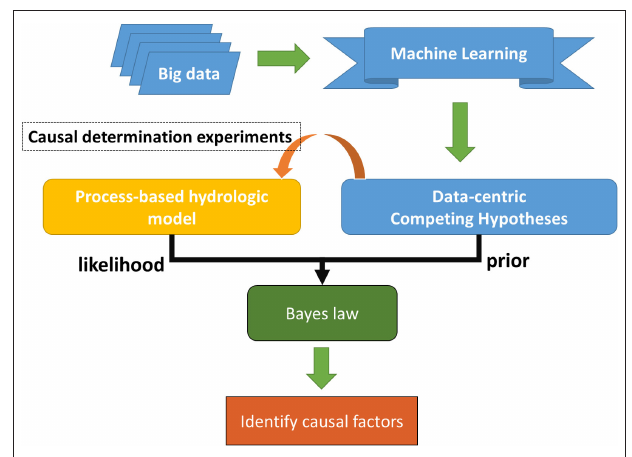
FIGURE 2 | A framework for integrating PBM and machine